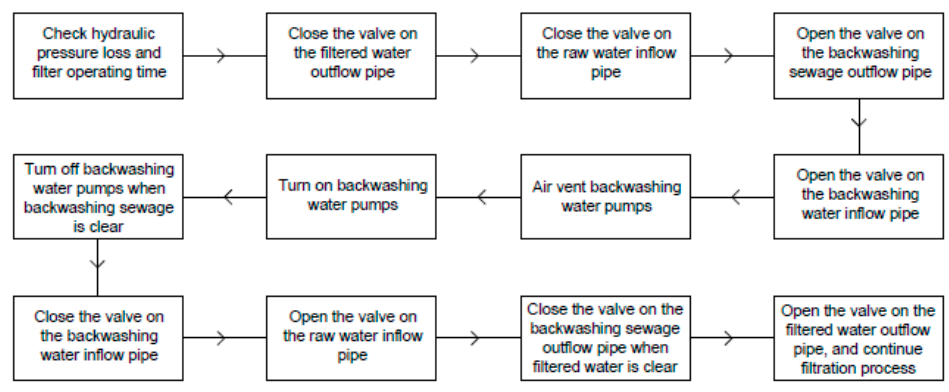
Figure 3. Filter backwashing procedure diagram.